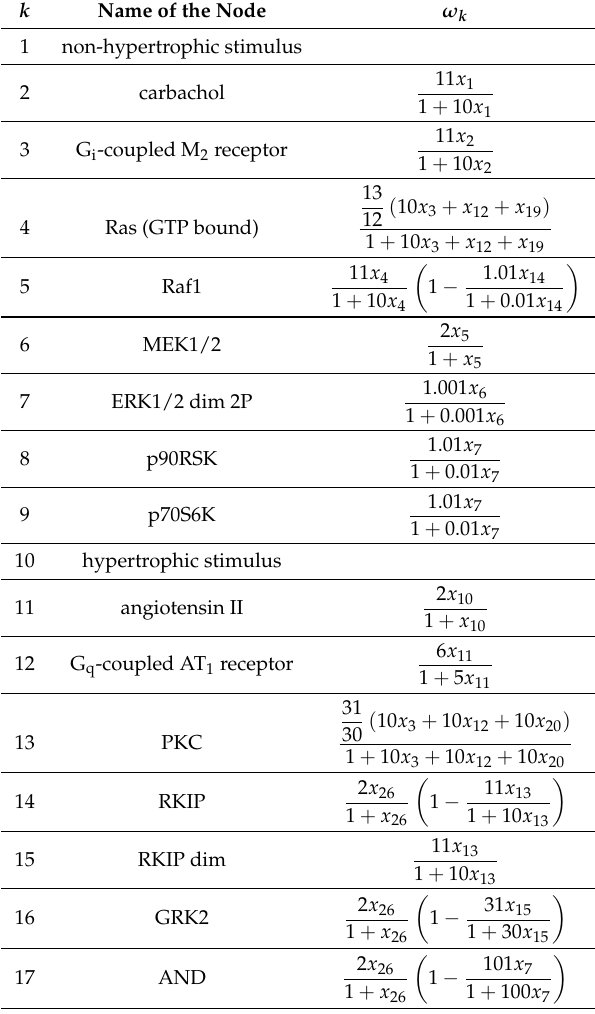
Table 1. Parameters for the network shown in Figure 2 according to the model (2.1) in the Supplementary